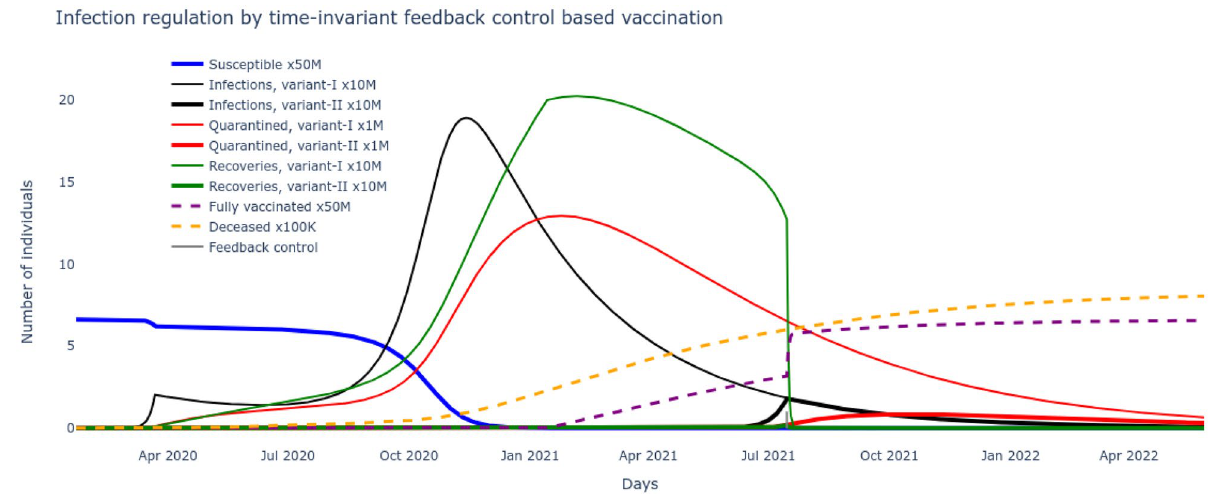
Figure 8. Suppressing the delta wave by time-invariant feedback control based